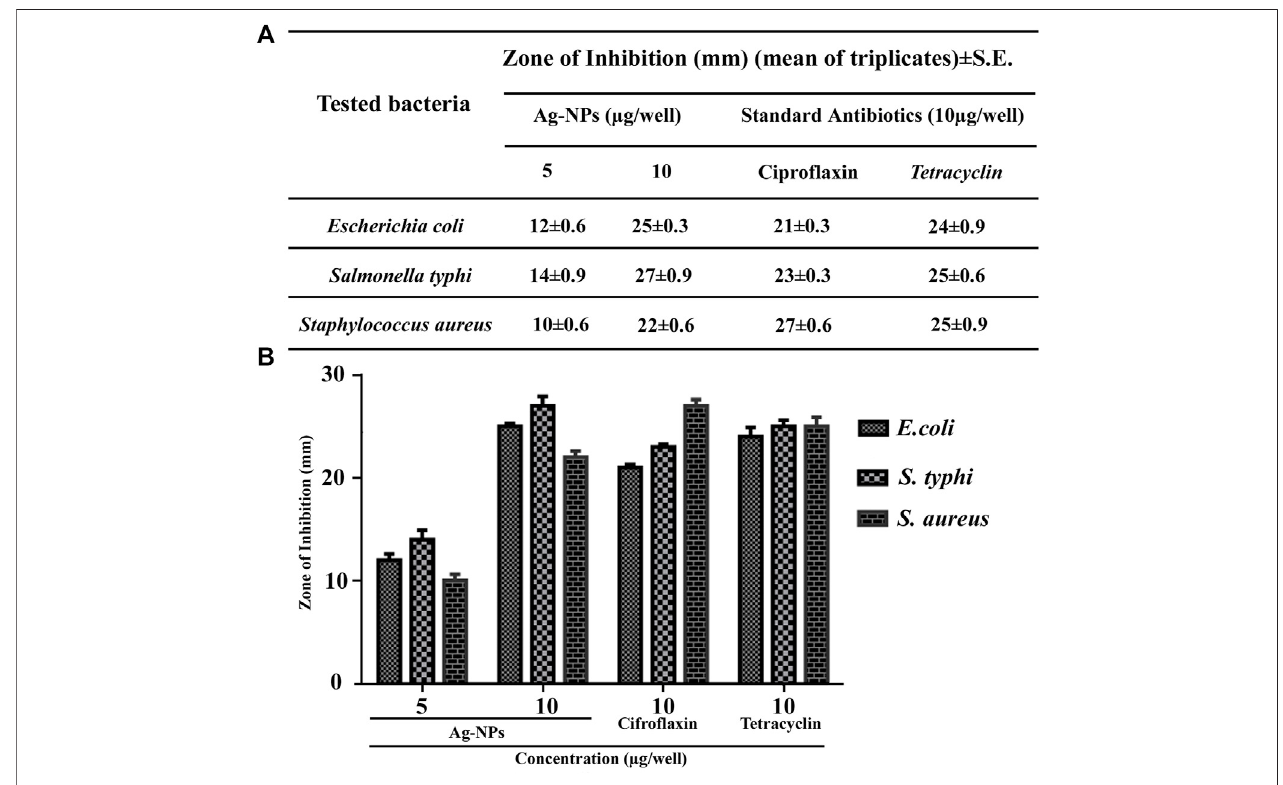
FIGURE4|(A,B) TabularandbarhistogramrepresentationshowingzoneofinhibitionofAg-NPswithrespecttostandardantibioticsagainstthetestedpathogenic bacteria.